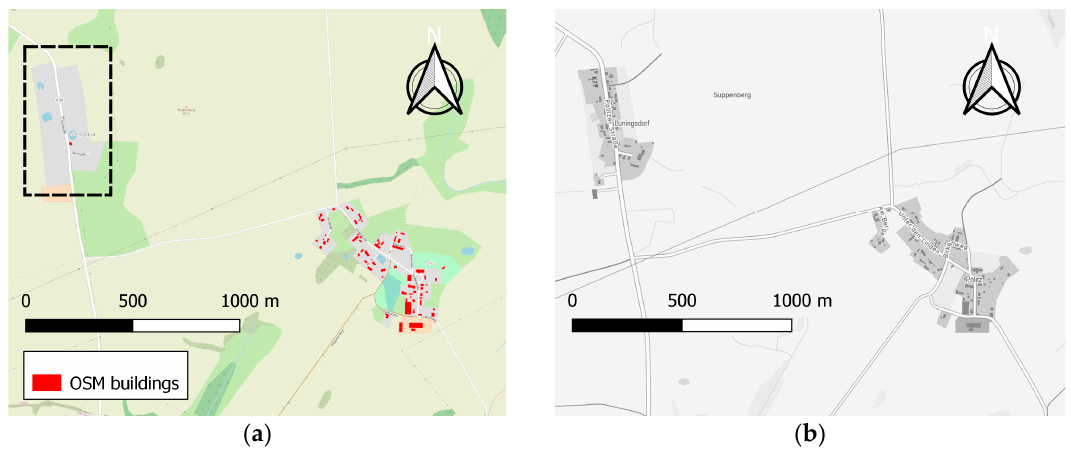
Figure 5. ( a ) OSM data; no buildings have yet been mapped in the western village (marked by the dashed line); ( b ) Digital topographic web map of the same villages (WMS MV WebAtlasDE/MV [46].)